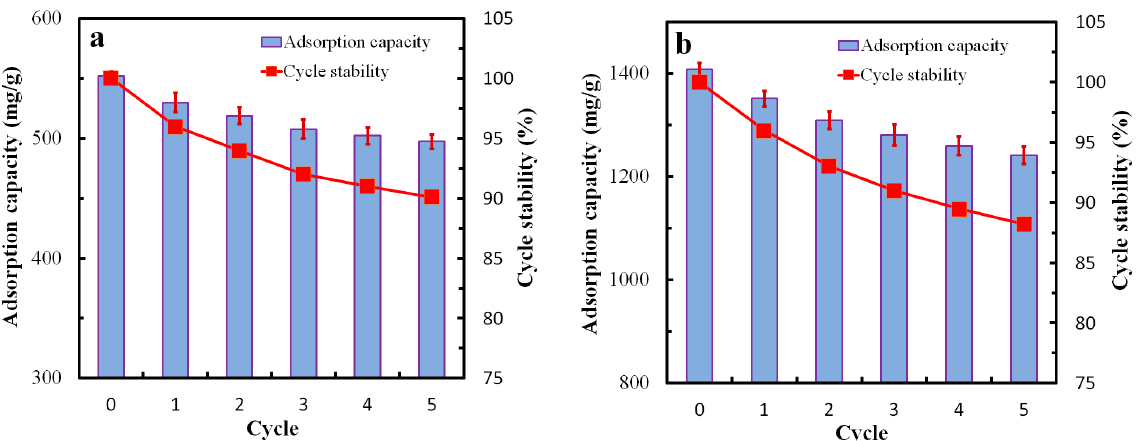
Figure 11. The adsorption–desorption cycle stability of the GQDs@ZIF-8 composite for toluene ( a ), and ethyl acetate ( b ).